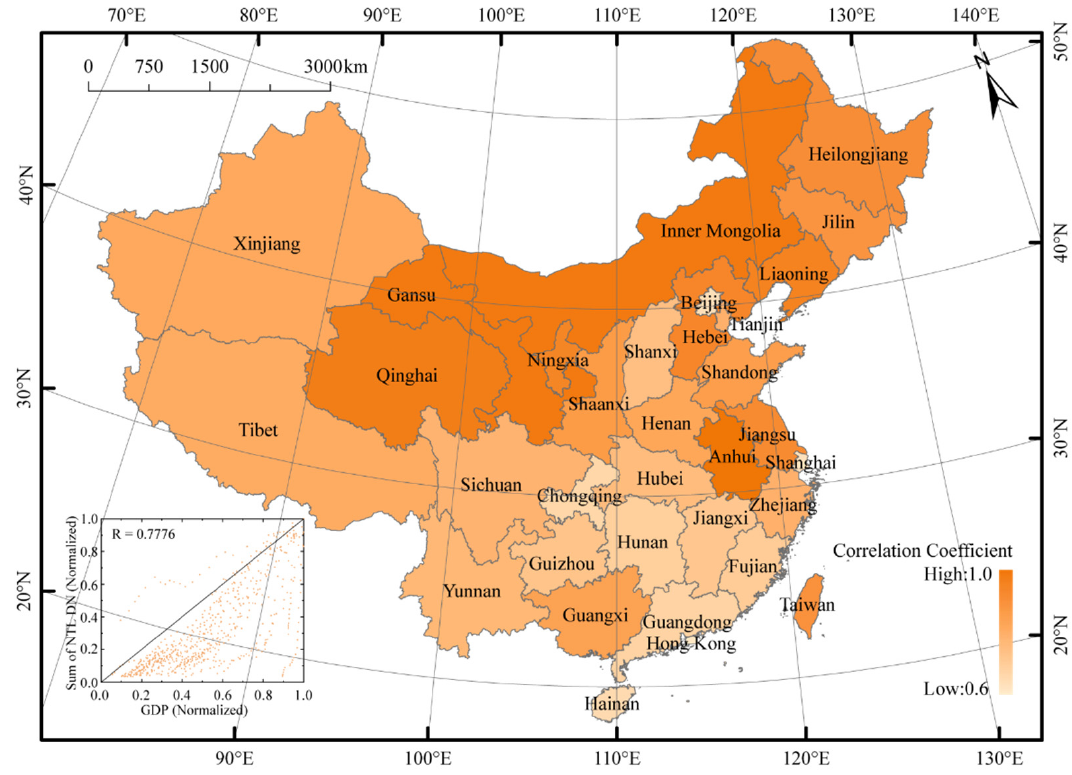
Figure 14. Correlation between the nighttime light data obtained by the improved stepwise calibration (ISC) method and GDP of provinces in mainland China (note: for data presentation purposes, only specific large provinces with significant GDP changes are shown, and some islands with insignificant GDP changes are not).